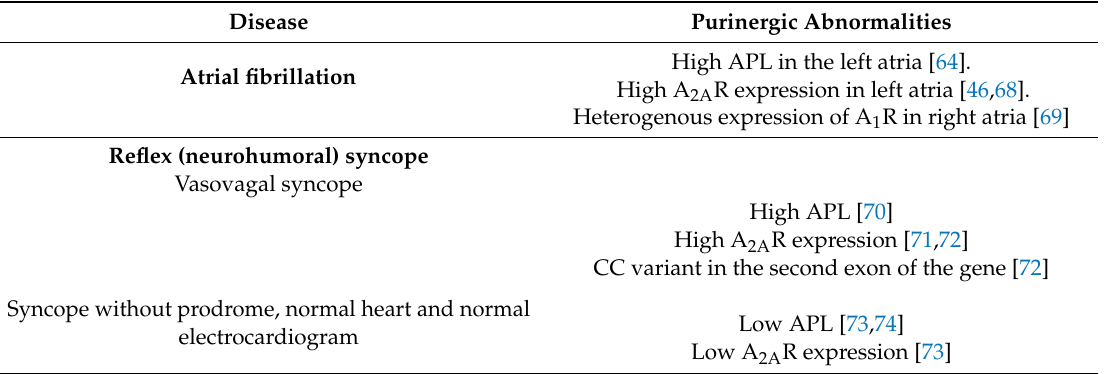
Table 1. Main purine abnormalities in human cardiovascular